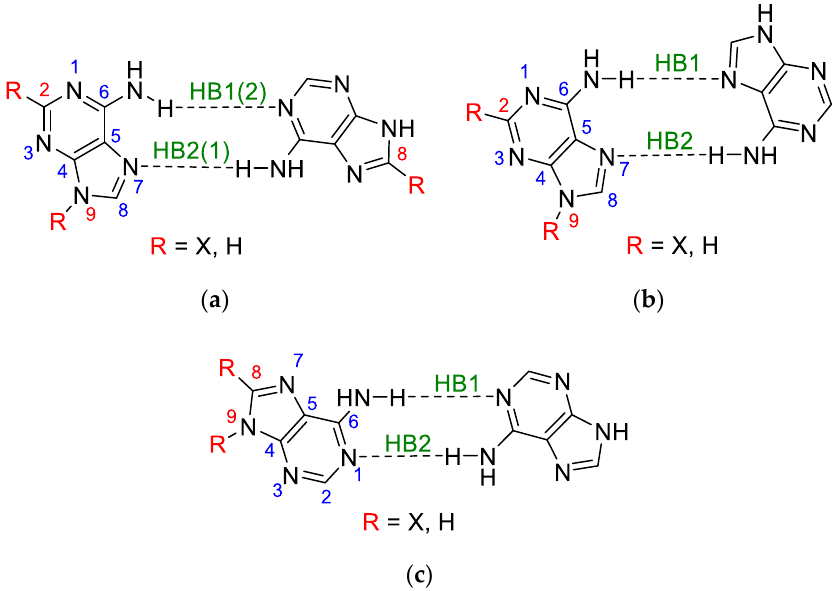
Figure 2. Adenine-adenine ( a ) AA2, ( b ) AA3, and ( c ) AA4 base pairs with the common numbering of adenine atoms and adopted hydrogen bond numeration (for AA2 C8-X dimer, numeration in brackets). Substitutable positions are marked in red color.